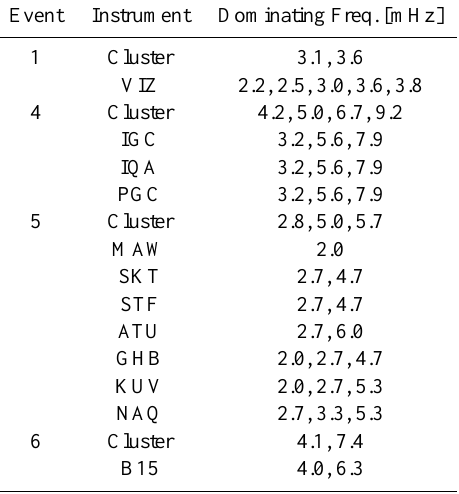
magnetic field PSD from Cluster, and the fifth frame plots the total magnetic field PSD from the VIZ ground magne- tometer station. The three highlighted columns through each PGC 3, 10, 0 plot represent the three dominating peaks in the frequency range. As the first and last columns consist of two frequen- cies, five frequencies are present in the ground data